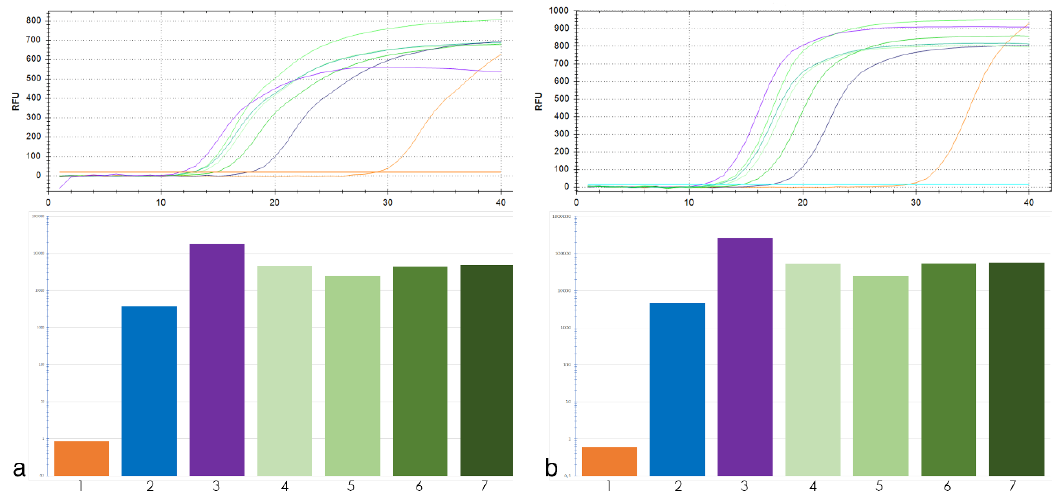
Figure 2. Top, amplification curves of 19-202 primers pair No. 1 ( a ) and No. 2 ( b ) tandem repeat. Colors of curves corresponds to target DNA: T. aestivum (orange), Th. intermedium (violet), Th. ponticum (blue), wheat–wheatgrass hybrid (WWGH) (shades of green). Bottom, the histogram of copy number 19-202 tandem repeat: 1— T. aestivum , 2— Th. ponticum , 3— Th. intermedium , 4—WWGH 166, 5—WWGH 548, 6—WWGH 4044, 7—WWGH ZP26.